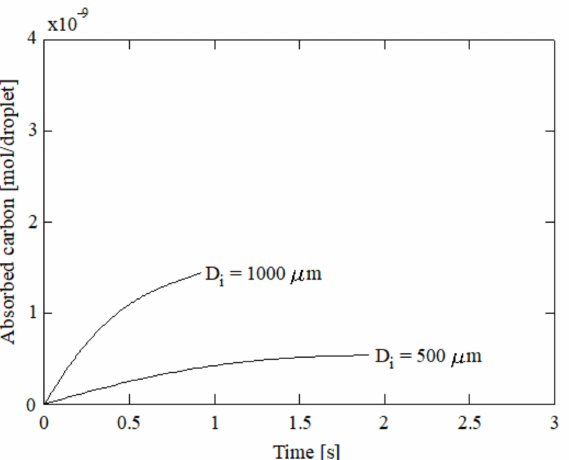
Figure 9. Carbon absorbed by a droplet for several initial diameters; 5% initial ammonia concentra- tion, 100 ◦ C initial gas temperature, and 5 ◦ C initial liquid